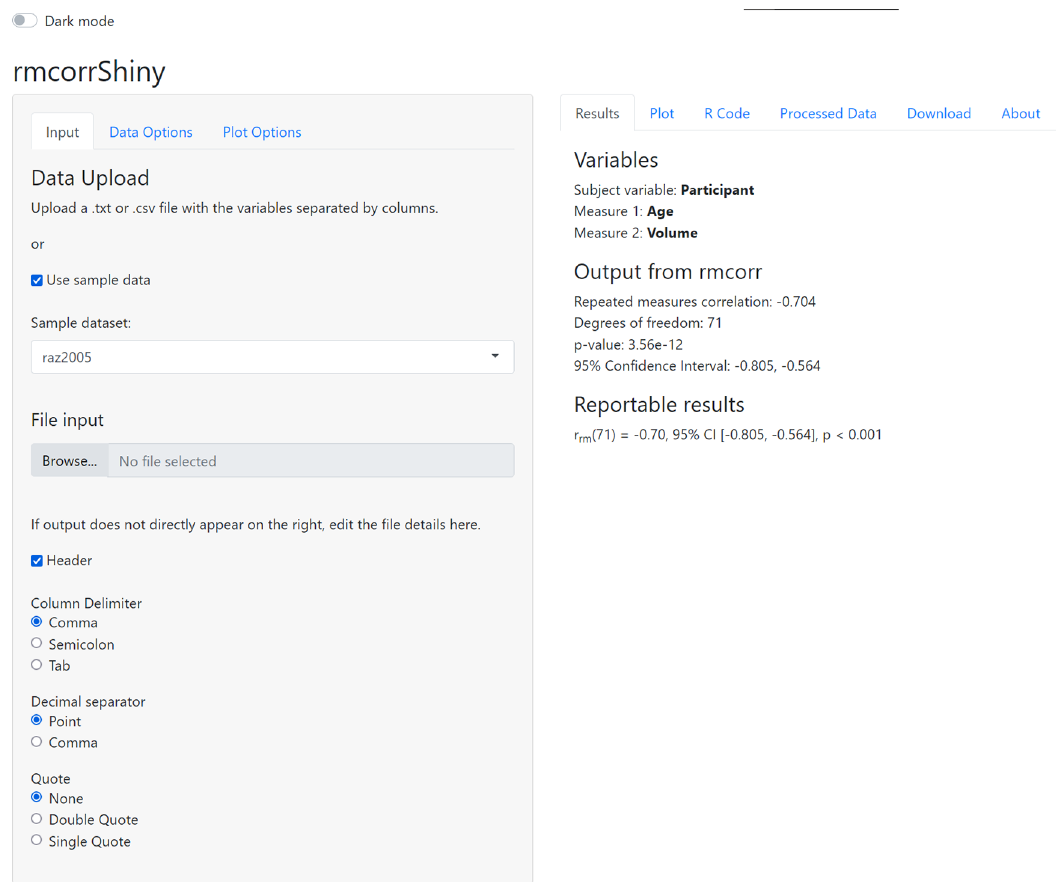
Figure 1. Graphical interface for